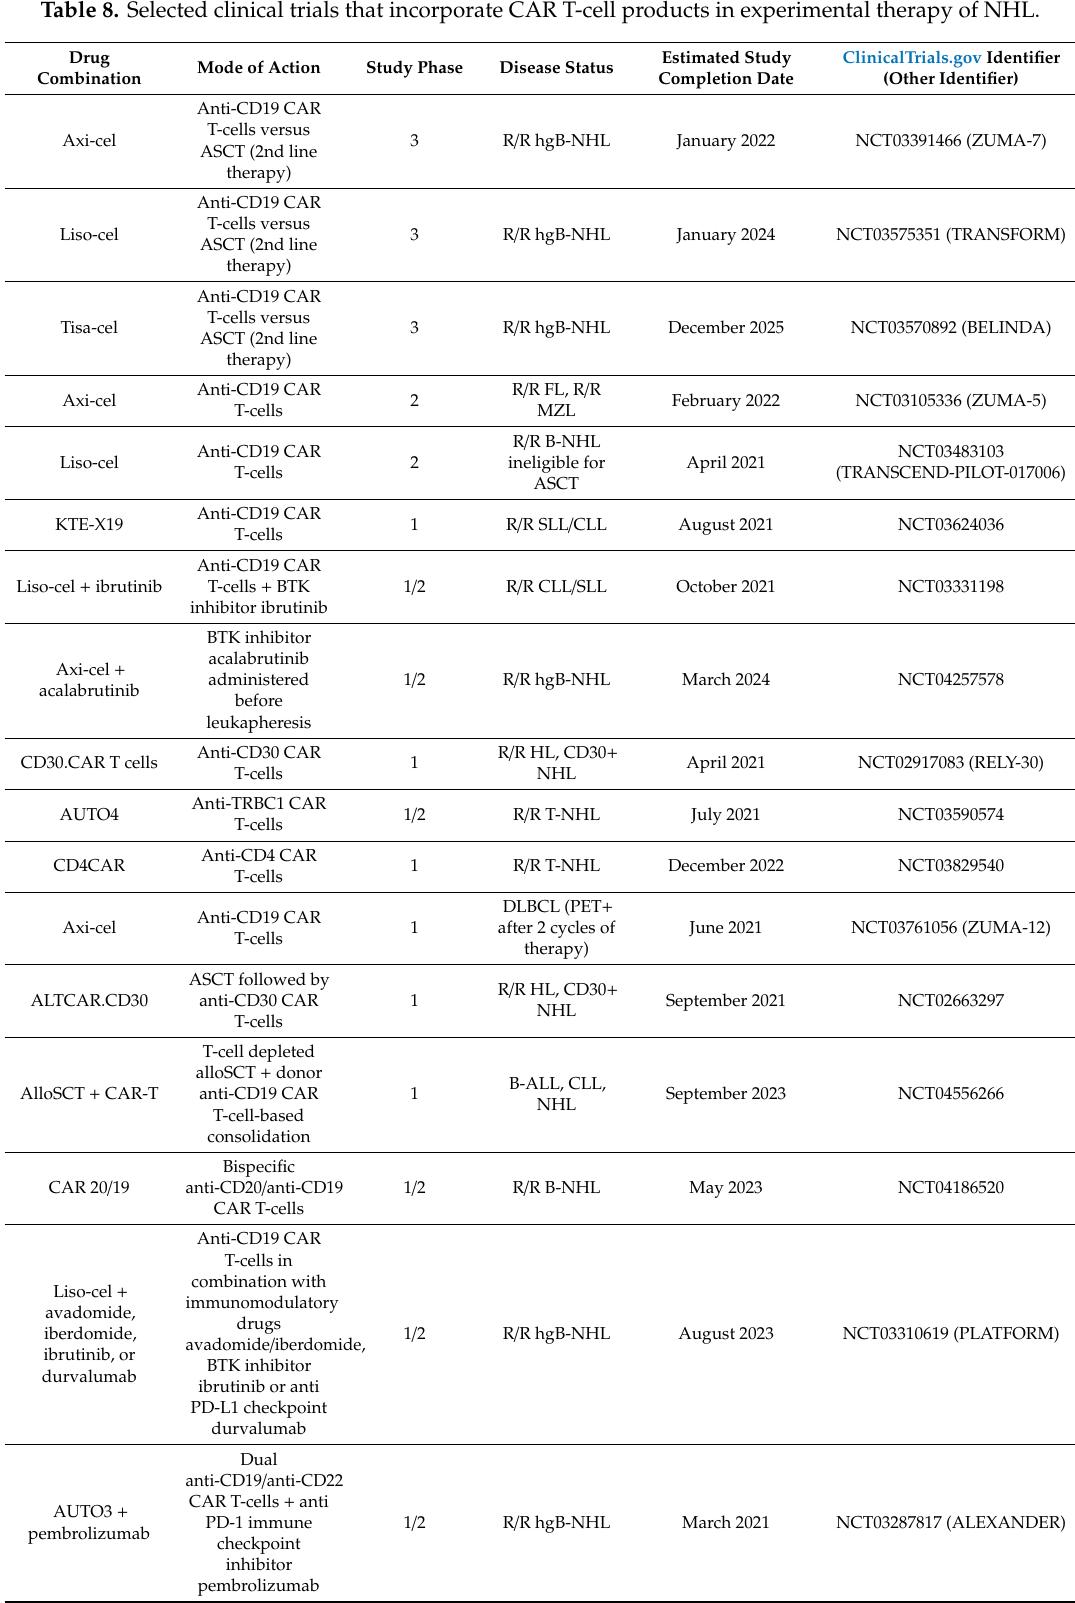
Table 8. Selected clinical trials that incorporate CAR T-cell products in experimental therapy of